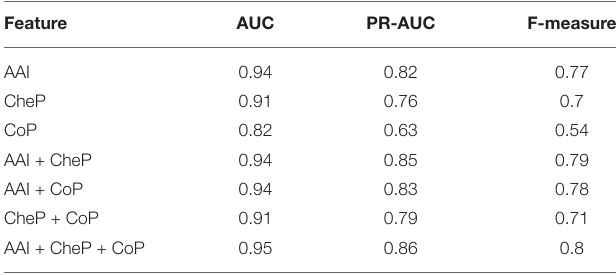
TABLE 5 | Experiment results of feature